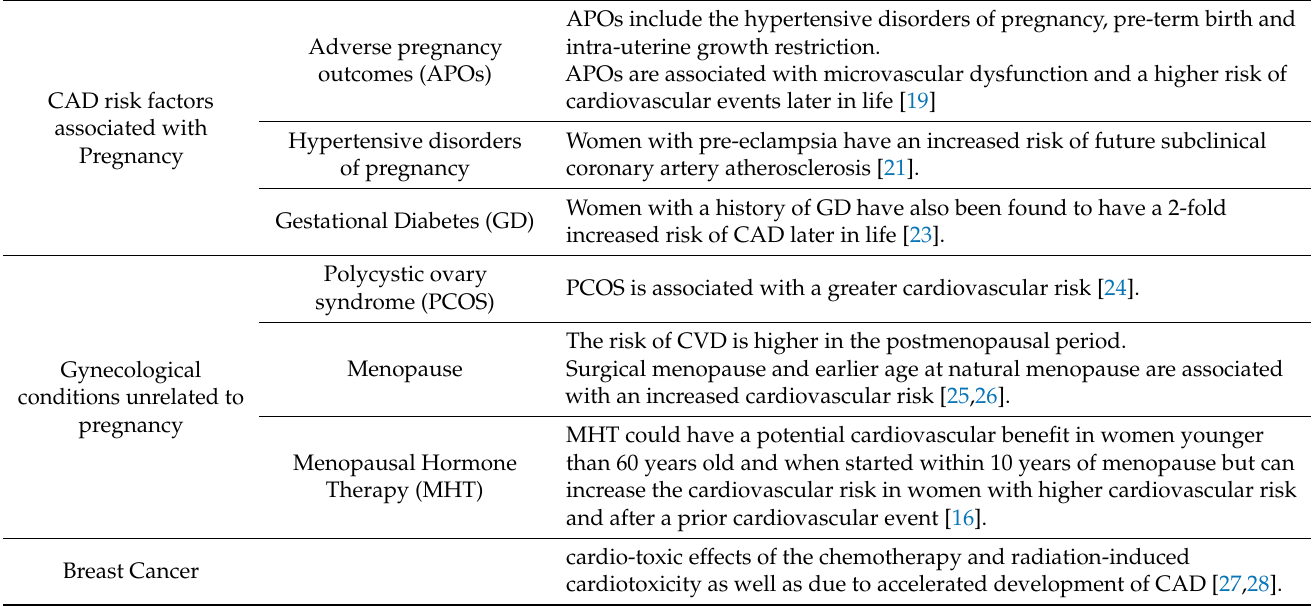
Table 1. Women-specific CAD risk